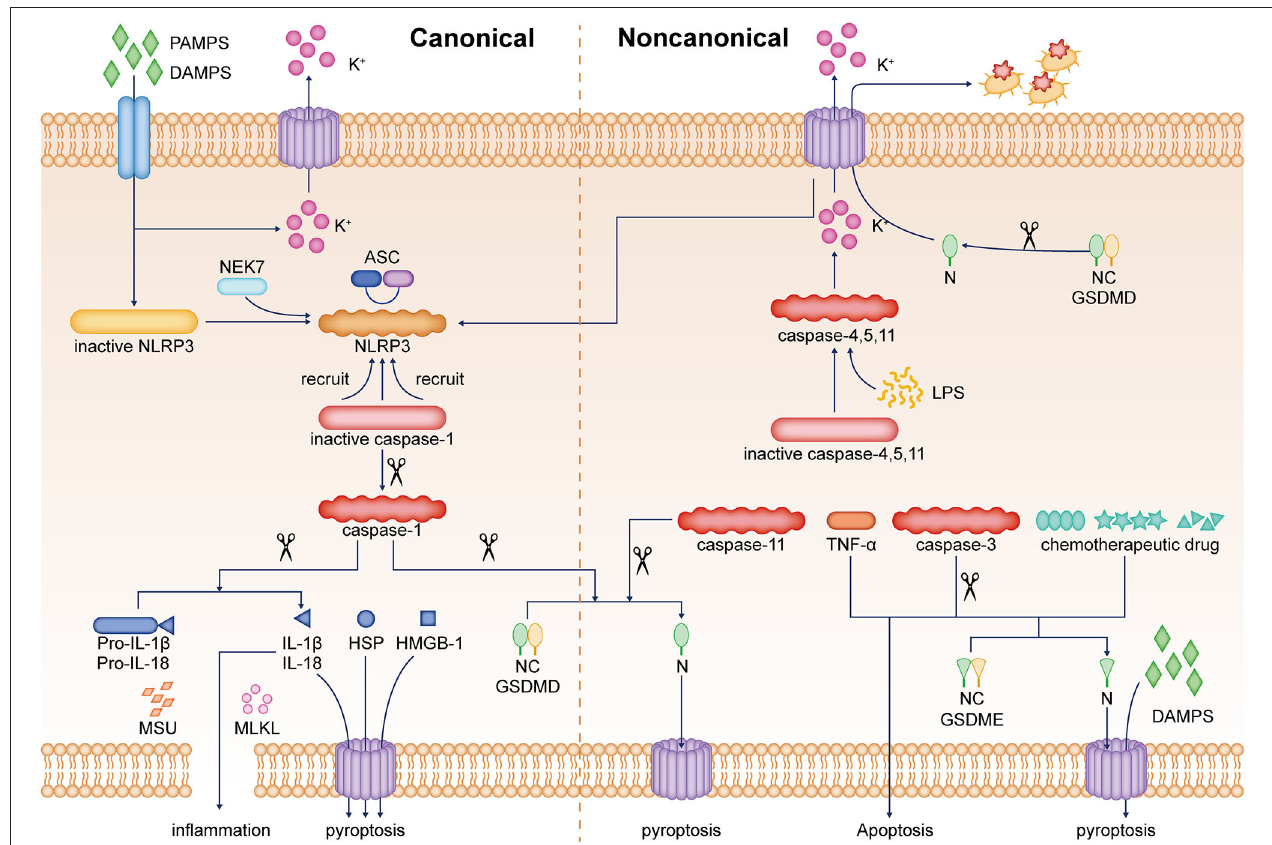
FIGURE 1 | Pyroptosis is an inflammatory cell death. The mechanism of pyroptosis can be divided into two pathways, namely, the canonical pathway mediated by caspase-1 and the non-canonical pathway mediated by caspase-4/-5/-11 or caspase-3. In the canonical pathway of pyroptosis, the sensors, such as NLRP3 inflammasome and PRRs, are activated by stimuli, including PAMPs, DAMPs, etc. In addition, NLRP3 is activated by potassium ion efflux and the binding of NEK7. NLRP3 recruits pro-caspase-1 through ASC. The recruited inactive caspase-1 is activated by a self-shearing mechanism. Caspase-1 rapidly cleaves the N-terminal part of GSDMD, thus eliminating the inhibitory effect of the C-terminal end on the N-terminal part and inducing pyroptosis. In a non-canonical pathway of pyroptosis, LPS directly activates caspase-4/5/11 and cleaves GSDMD, causing GSDMD-mediated potassium ion efflux, which in turn promotes NLRP3 inflammasome activation in the canonical pathway. Other membrane-damaging substances, such as MLKL or MSU, can also induce cell membrane damage and promote IL-1 β release by mediating the phosphorylation of mixed-lineage kinase structural domains. In addition, the cleavage of GSDME can convert TNF- α , chemotherapeutic drugs, and caspase-3-mediated apoptosis into pyroptosis and promote the release of DAMPs. The N-terminal segment released by GSDMD cleavage can also directly kill bacteria outside the host cell. HMGB1, high mobility group box-1 protein; HSP, heat shock protein; PAMPs, pathogen-associated molecular patterns; DAMPs, damage-associated molecular patterns; NEK7, NIMA-related kinase; ASC, adapter protein apoptotic speck-like protein; LPS, lipopolysaccharide; TNF- α , tumor necrosis factor α ; MLKL, mixed-lineage kinase domain-like protein; MSU, monosodium urate crystal; PRRs, pattern recognition receptors; NLRP3,